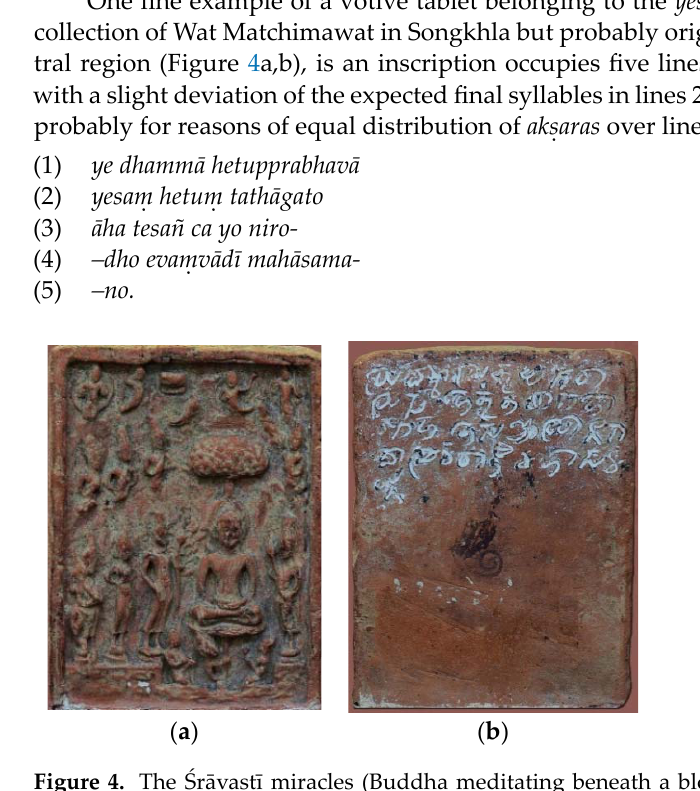
Figure 3. The Ś r ā vast ī miracles (Buddha meditating beneath a blooming tree and the n ā ga ) with ye dhamm ā formula. Ca. the second half of the 7th century CE. Ratchaburi province. Moulded tablet, clay; h. 14 × w. 11.5 cm. Ratchaburi National Museum (No. 242/2533). ( a ) Font Side; ( b ) back Side.